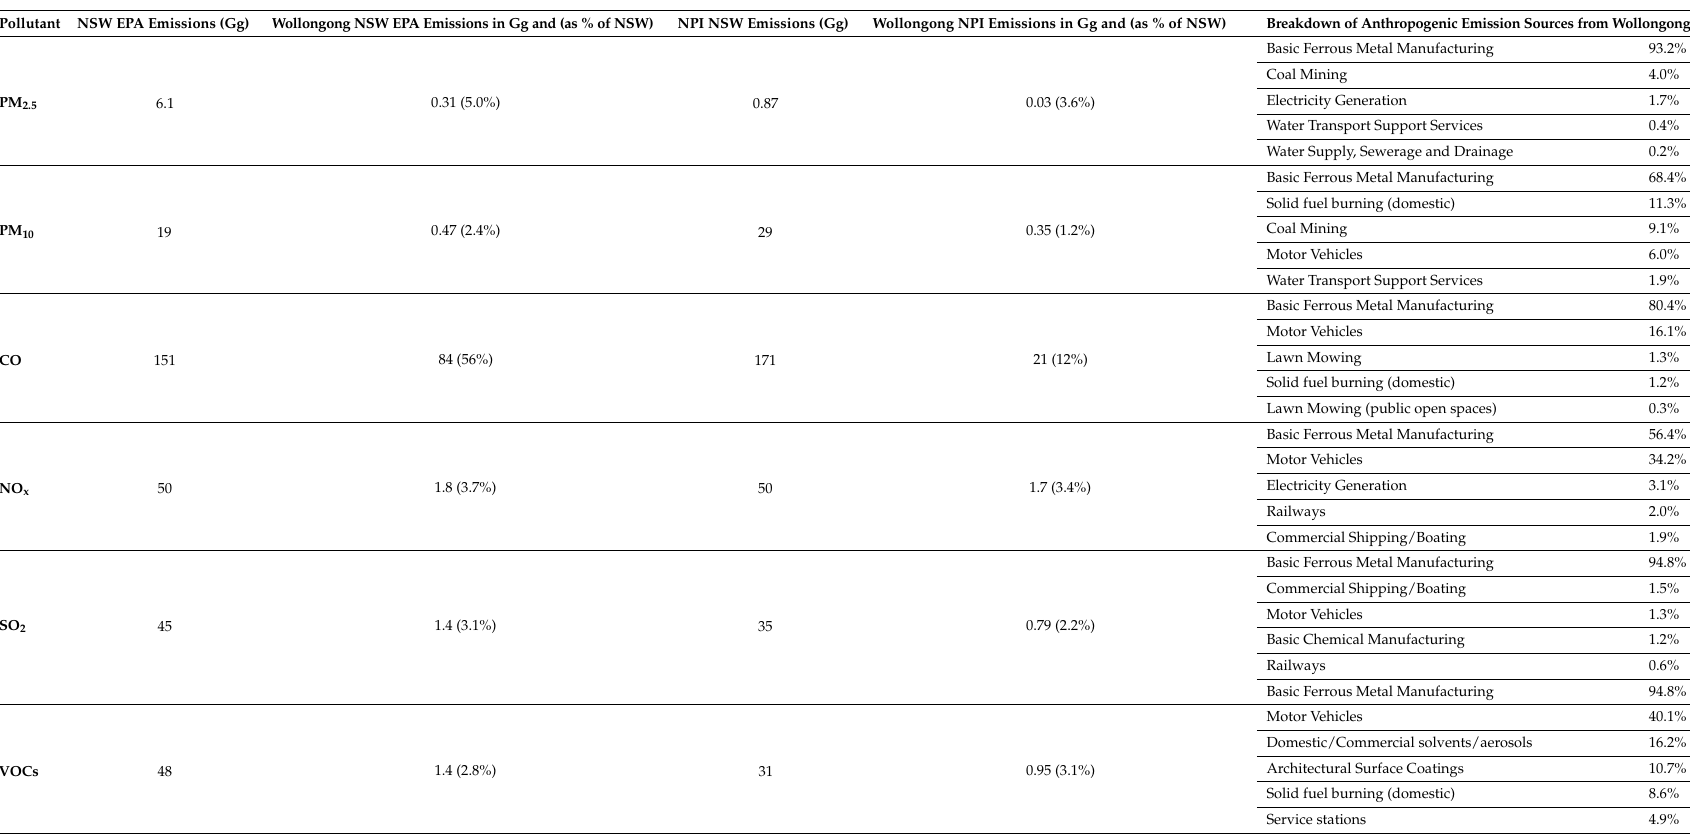
Table 1. Comparison of emissions within New South Wales (NSW) and Wollongong estimated in the National Pollution Inventory (NPI) for 2012/2013 and the NSW EPA inventory for 2008. Column 2 and 4 give the total NSW emissions in Giga-grams (Gg) for the 57 days of the MUMBA campaign from the 2008 NSW EPA inventory and the 2012/2013 NPI database respectively for each pollutant listed in Column 1. Column 3 and 5 show the emissions just from the Wollongong region in Giga-grams and as a percentage of the total NSW emissions from the 2008 NSW EPA inventory and the 2012/2013 NPI database respectively. Column 6 shows the five most significant anthropogenic source types within the Wollongong region in the